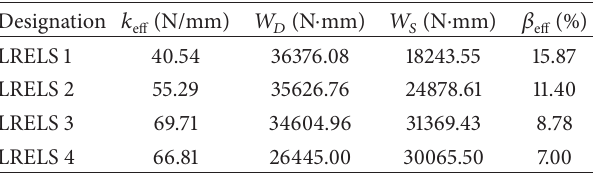
Table 5: Effective stiffness, damping, and energy dissipation in the in-plane horizontal direction.